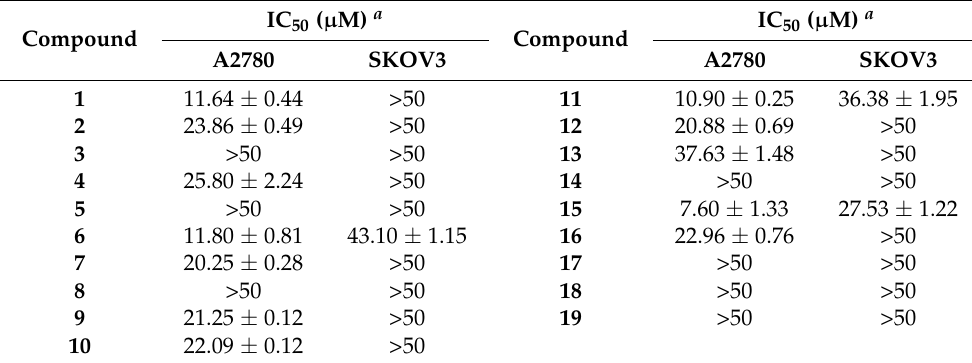
Figure 4. The effects of compounds 1 − 2 , 4 , 6 − 7 , 9 − 13 , and 15 − 16 on cell viability in epithelial ovarian cancer cells A2780. The results are presented as mean standard ± SD and were processed by using a one ‐ way ANOVA. * p < 0.05 in comparison to control (0 μ M). Table 3. The cytotoxicity of compounds 1 − 19 isolated from P. ginseng in A2780 and SKOV3 human ovarian cancer cells.